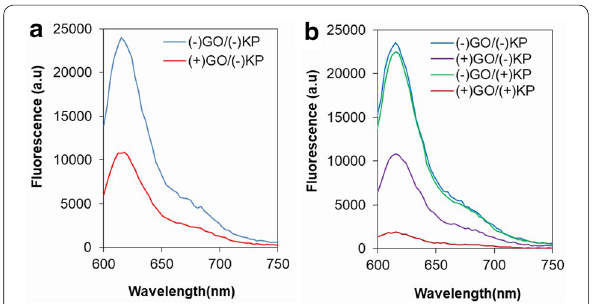
Fig. 1 Fluorescence spectra of ssDNA before a and after b irradiation of UVB light in the absence (